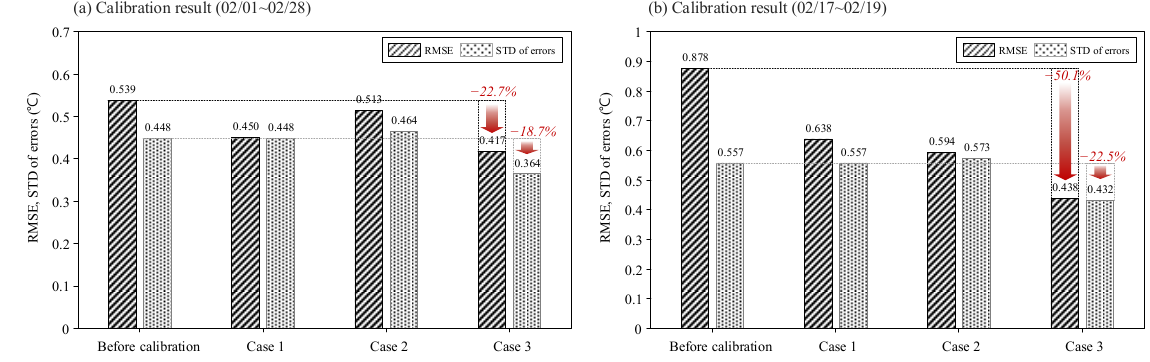
Figure 7. Comparison of virtual sensor performance, displayed according to cases, for the validation period (February 2021).